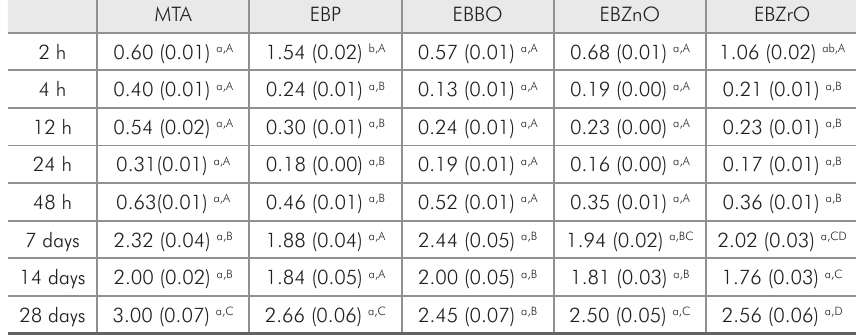
Table 3 - Mean values and standard deviation for calcium ions (mg/dL) released at the different time intervals tested.